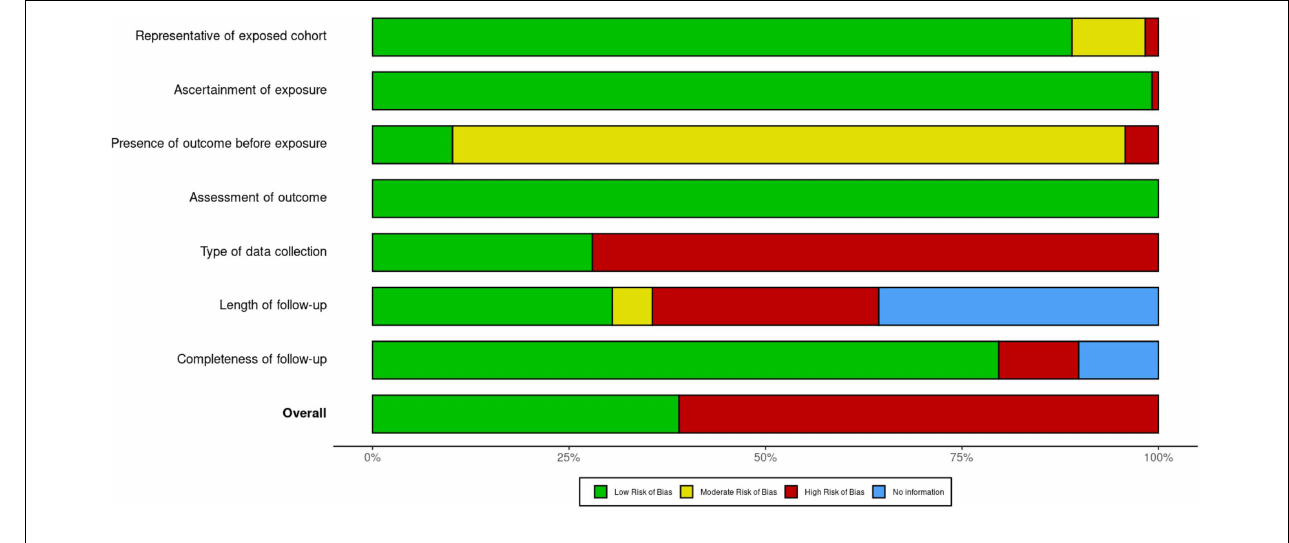
FIGURE 2 | Summary of risk of bias judgments for included studies.